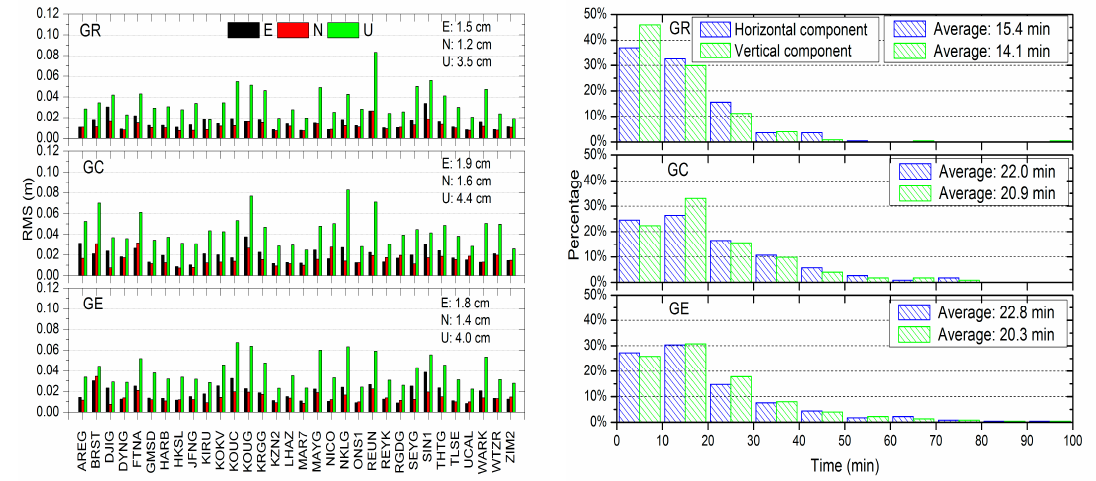
Figure 11. The positioning RMS of the dual-system combined PPP in the east, north, and upward coordinate components ( left ), and the convergence time statistic of the dual-system combined PPP in the horizontal and vertical components ( right